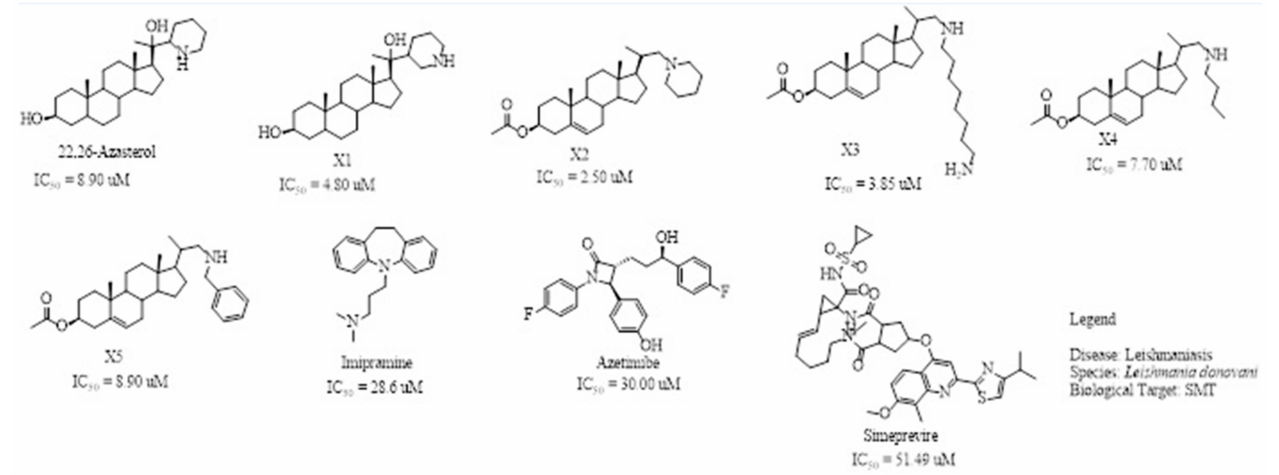
Figure 1. Chemical structures of some known inhibitors of Leishmania donovani sterol methyltrans- ferase and their IC 50 values. The biological target is sterol methyltransferase (SMT).